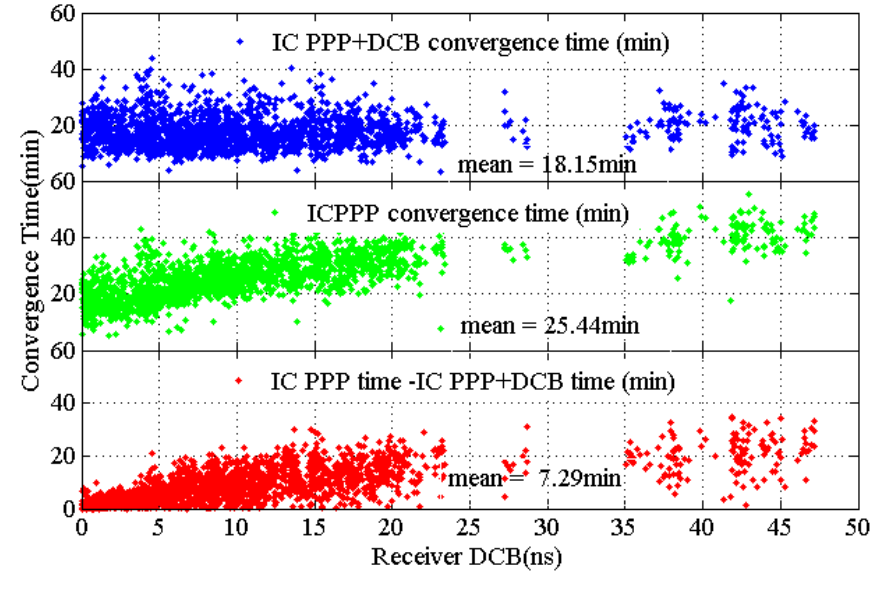
Figure 6. Relationship between receivers DCB magnitude and PPP convergence time in IC-PPP +DCB ( Top ) and IC-PPP ( Middle ) and the differences of their convergence time. The convergence time increases along with the receiver DCB if DCB is not estimated (middle), whereas a unique convergence time is needed for IC-PPP +